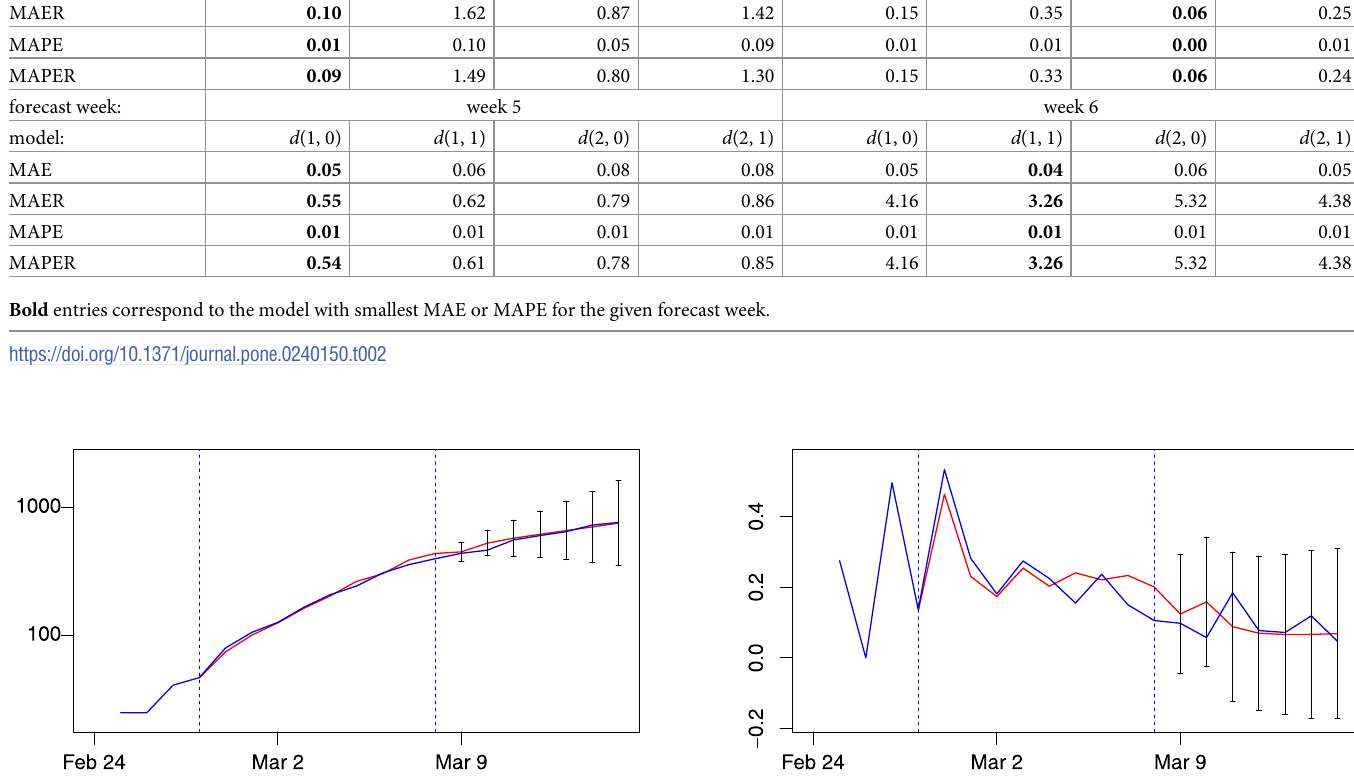
Fig 4. Lombardy forecast for week 3, model d (1, 0). Blue: actual; red: fitted (in estimation sample) or forecast (out-of-sample). Left: number of patients admitted in ICU. Right: % change of patients admitted in ICU. Training sample: February 28–March 8. Out-of-sample period: March 9–15. Forecast intervals ± 3 forecast standard errors.